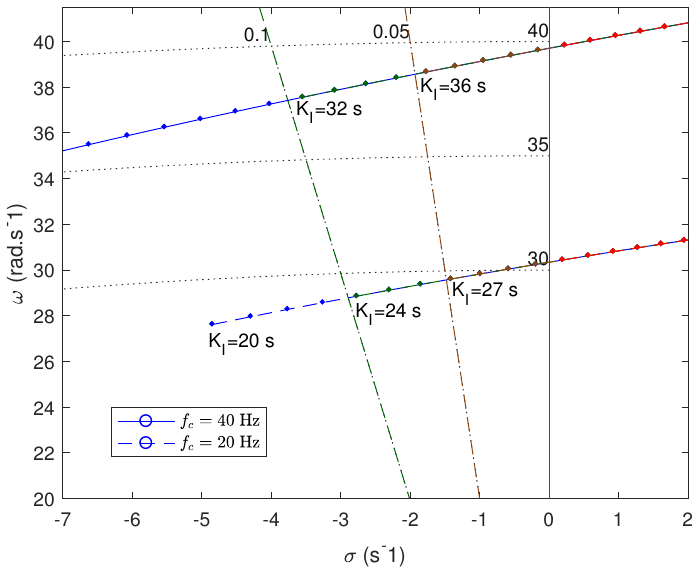
Figure 7. Stability locus of most critical pole showing the maximum virtual inertia gain for given values of f c in SMSIB system. Damping ratio of 0.05 and 0.1 are shown in the